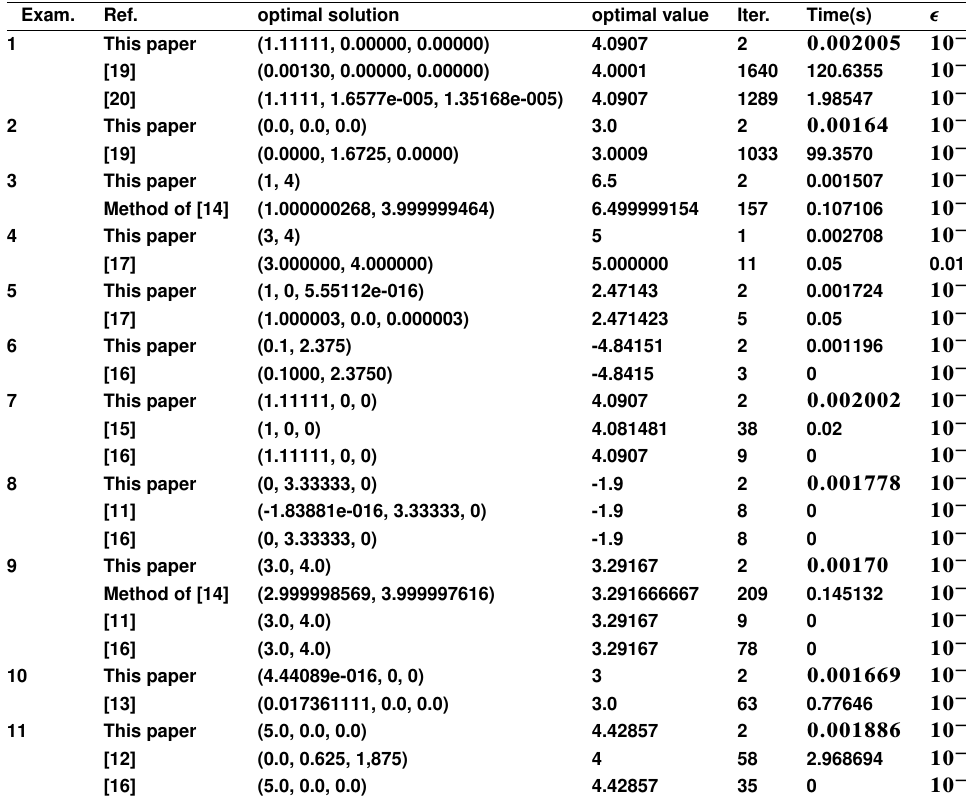
Table 1. Numerical results for Examples